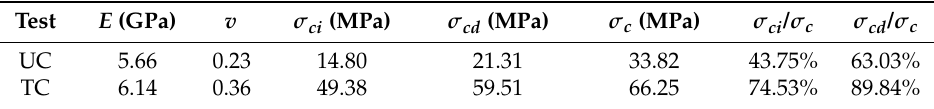
Table 2. The coal properties and threshold stresses for progressive